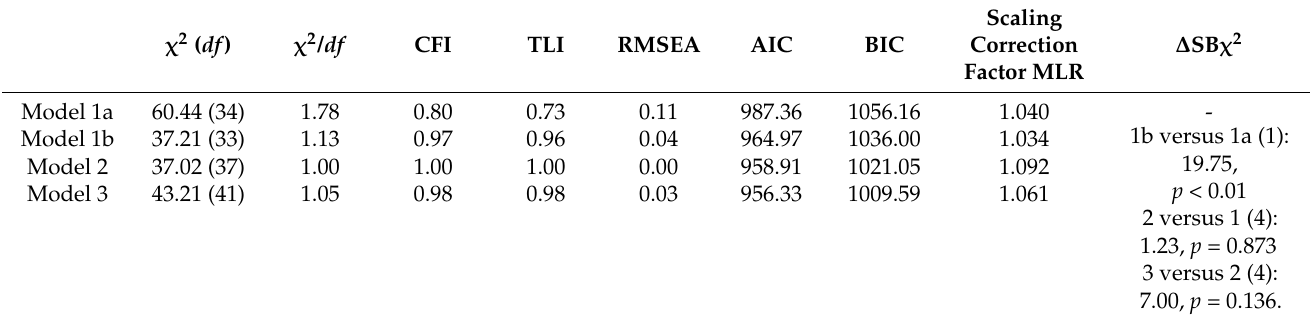
Table A3. Model Fit Indices for Testing Measurement Invariance PBS